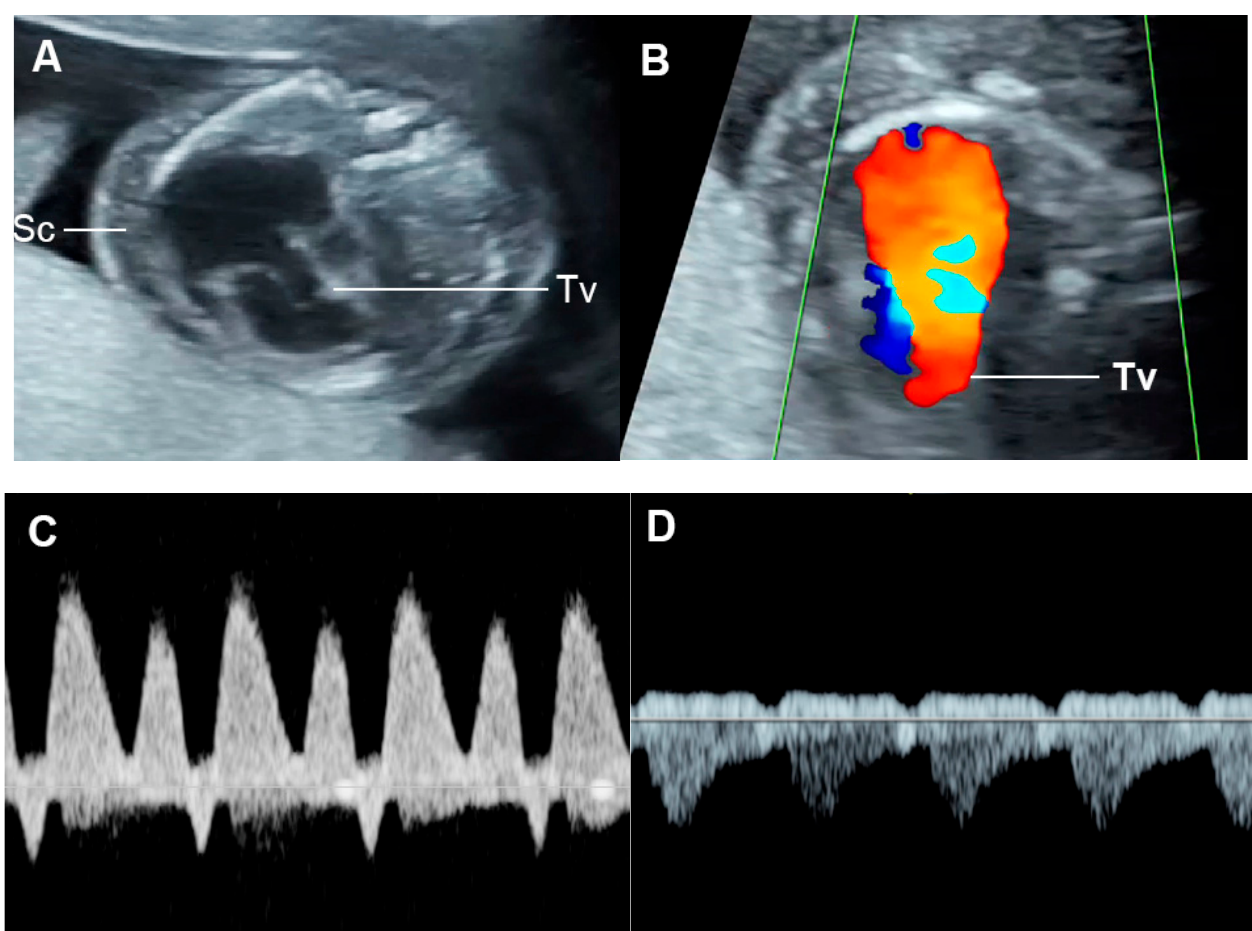
Figure 10. Ebstein anomaly with hydrops fetalis: ( A ) four-chamber view: cardiomegaly, low inser-tion of septal leaflet of the tricuspid valve (Tv) and subcutaneous edema (Sc); ( B ) color flow mapping of the four-chamber view: severe tricuspid regurgitation with originating point near the apex; ( C ) ductus venosus Doppler: reversed A-wave; ( D ) venous pulsations of the umbilical vein.